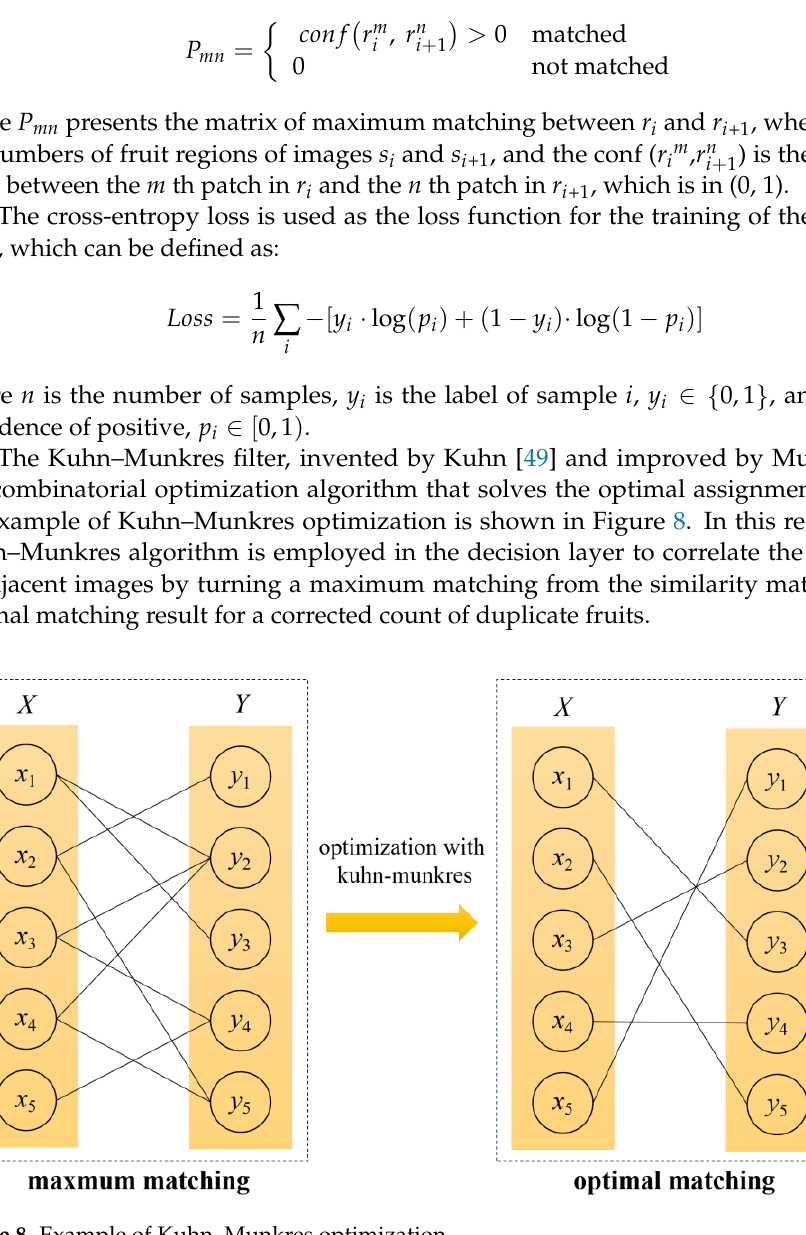
Figure 8. Example of Kuhn–Munkres optimization.